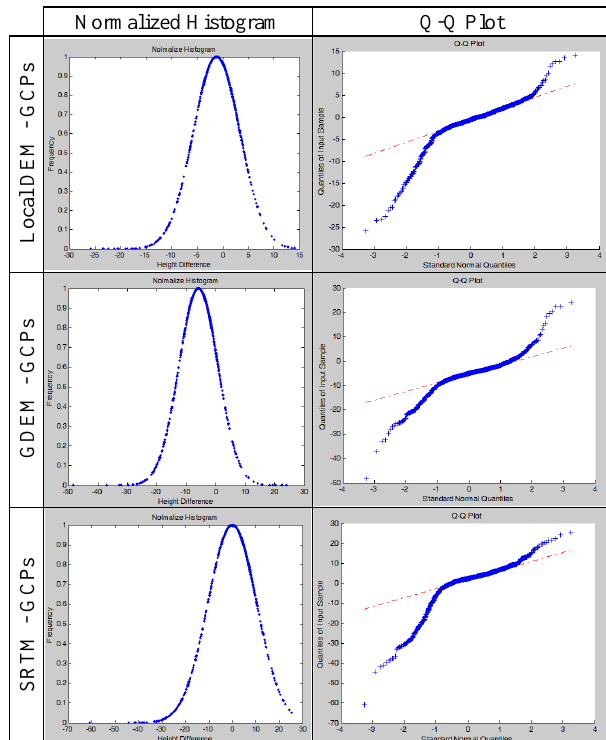
Figure 5. Left column: Normalized histograms, Right column: Q_Q